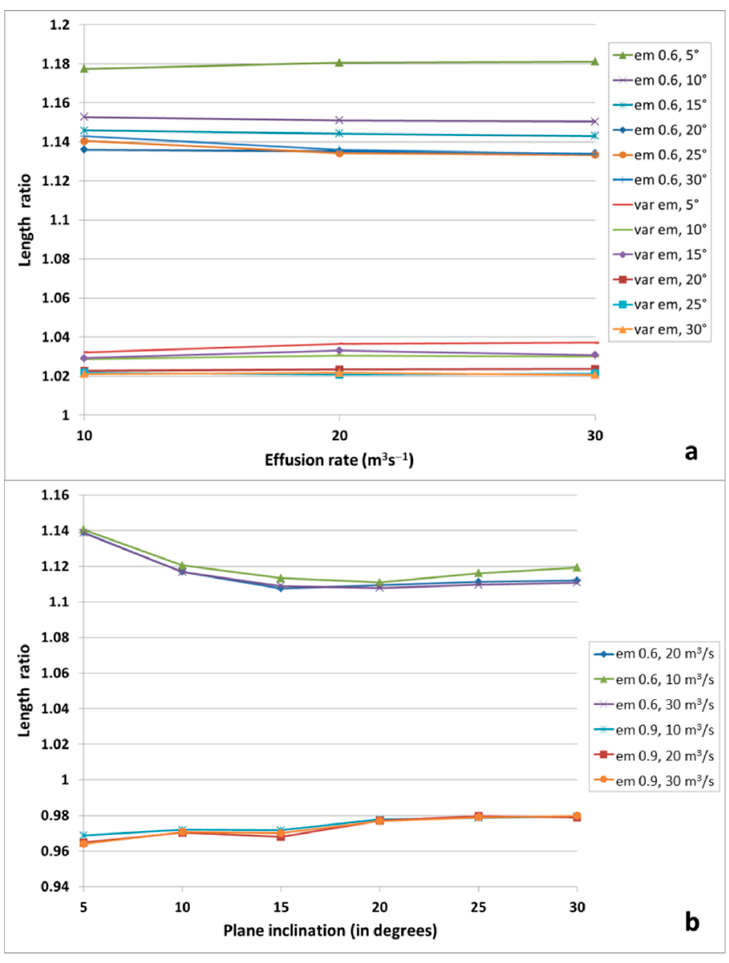
Figure 1. Length ratio of the lava flows simulated with a constant emissivity of 0.6 and 0.9 vs. variable emissivity, by varying the effusion rate ( a ) and the inclination of the plane used as DSM ( b